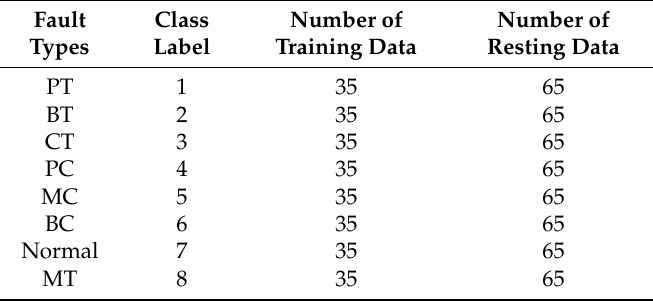
Table 2. The detailed description of sample numbers for Scenario